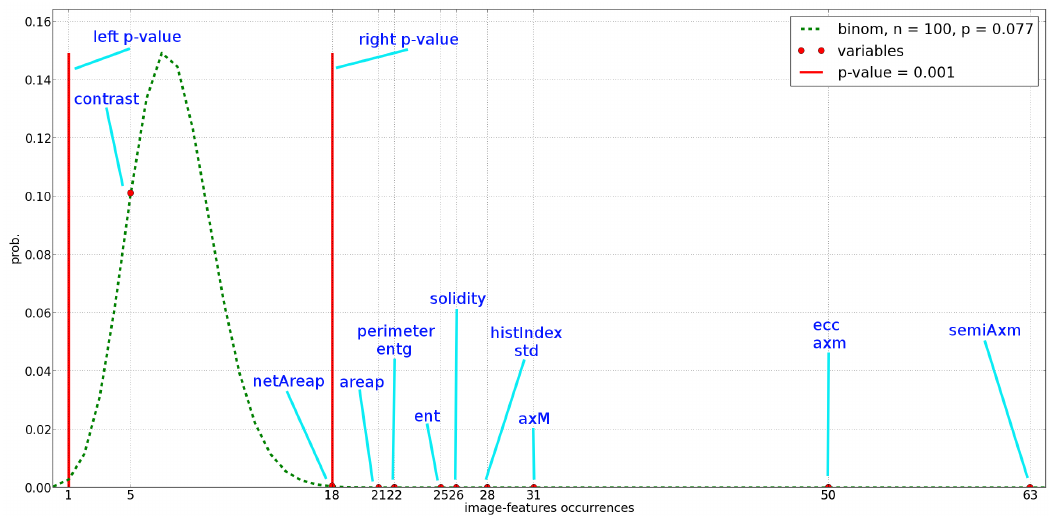
Figure 5. Relevance of the image-feature, according to the test statistics discussed in Section 2.4.3. The abscissa represents the occurrences of the image-features within the population pool. The ordinate represents the probability an image-feature occurred in the population pool is selected. The two red vertical lines represent the two-tails p -values.